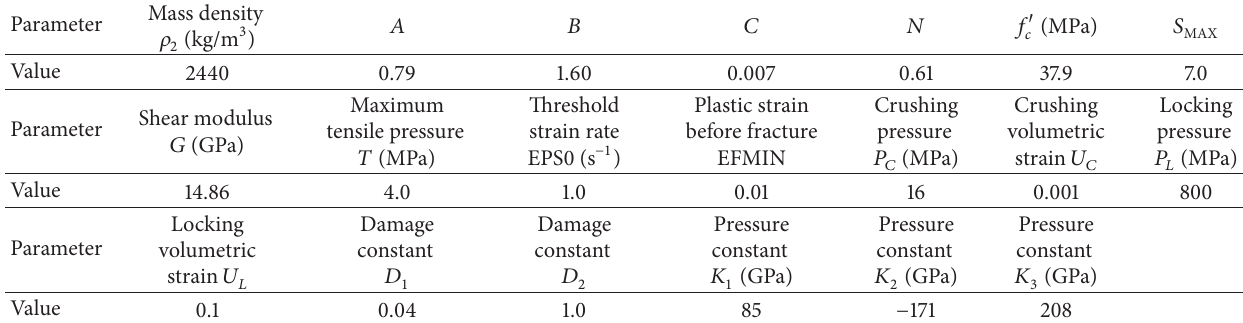
Table 2: Material parameters of the infill concrete.